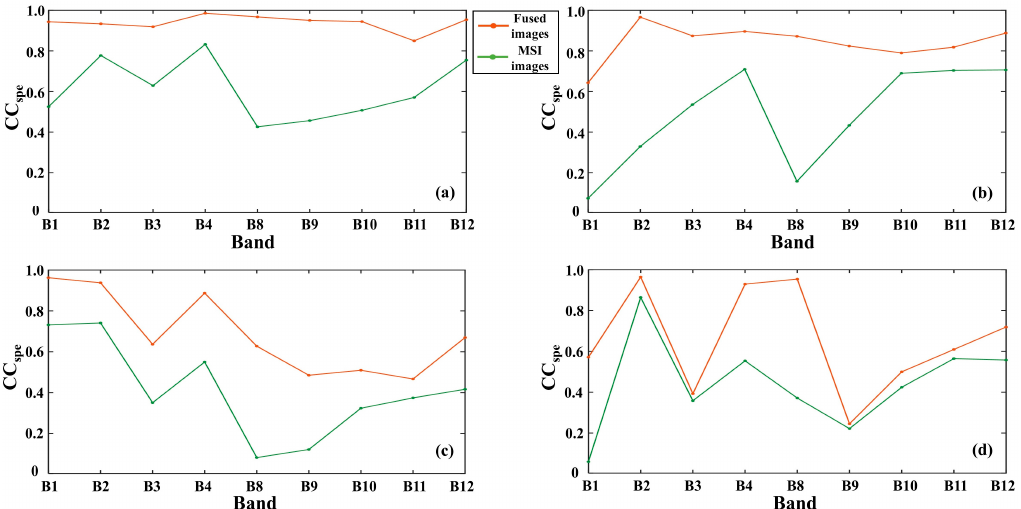
Figure 8. Spectral comparisons of fused and MSI images for four different dates. ( a ) 2 August 2018;